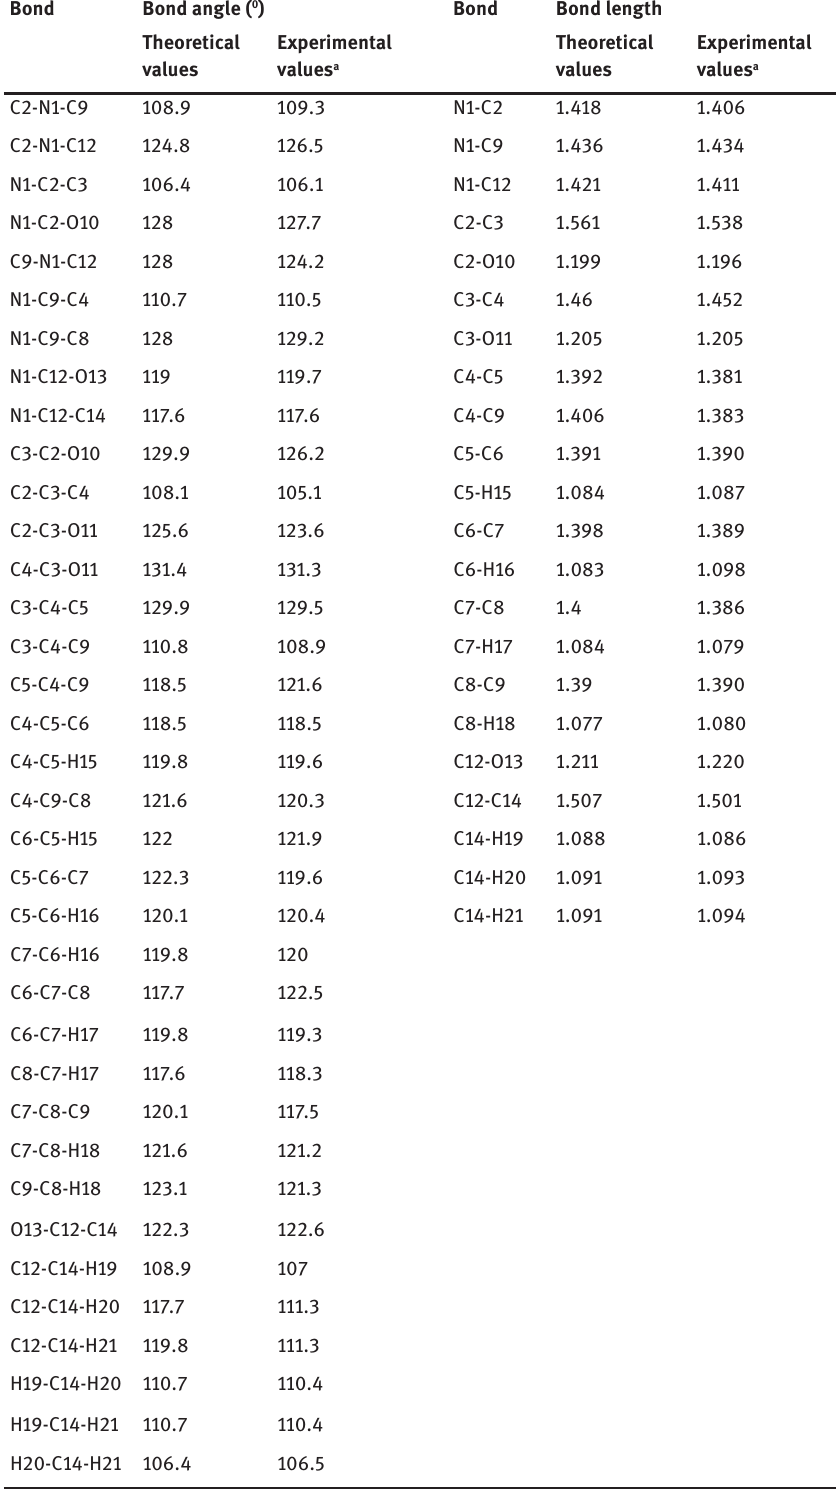
Table 1: Optimized geometrical parameters bond length, bond angle of the title molecule BYLYP/6-311++G(d,p) in comparison with experimental